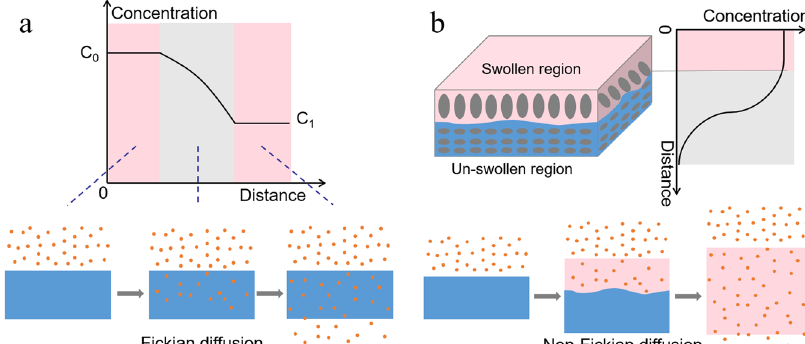
Fig. 4 Distribution models of active ingredients in the fi lm/coating during diffusion. a Fickian model b non-Fickian